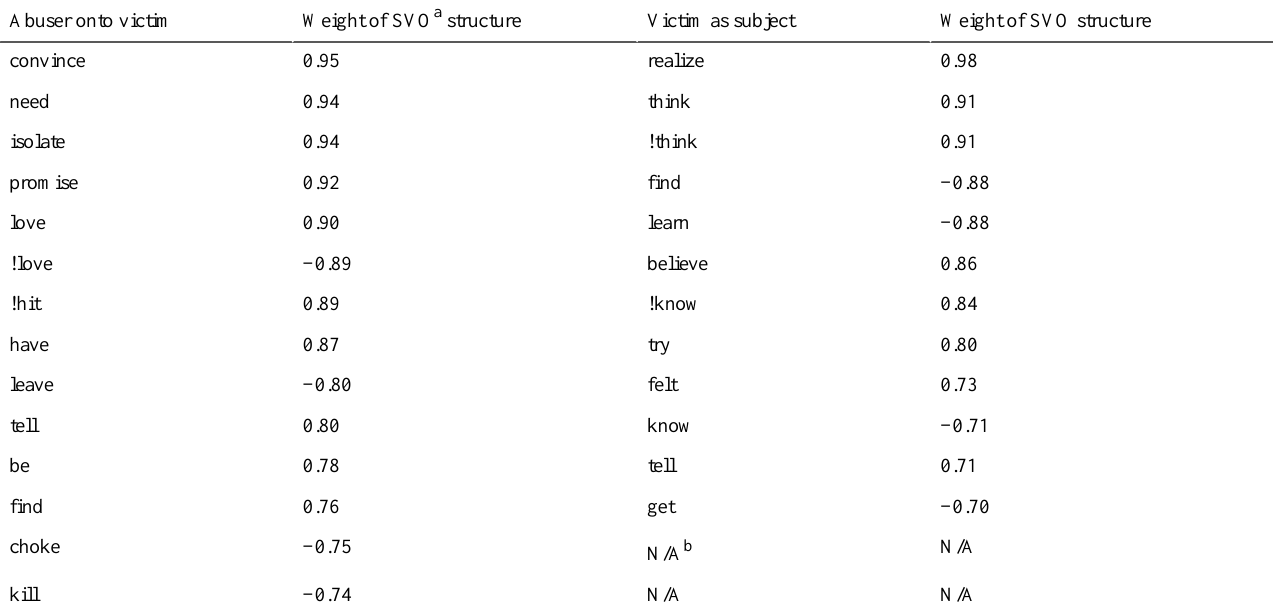
Table 5. The most indicative (in the direction of staying) verbs for abuser onto victim and victim as subject in the tweets having subject verb object structures. An exclamation point (!) before a verb indicates negation (eg, the phrase he did not love me would give the verb !love). Each cell indicates the weight of each subject verb object structure, as an support vector machine